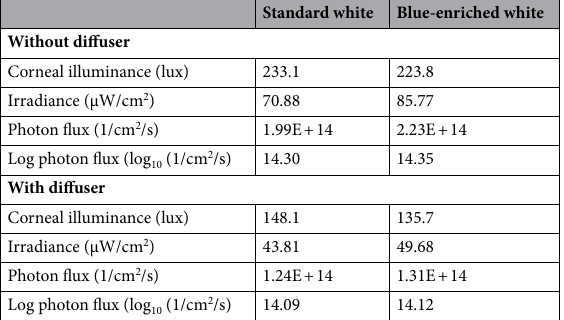
Table 1. Characteristics of experimental lighting environments in both groups.